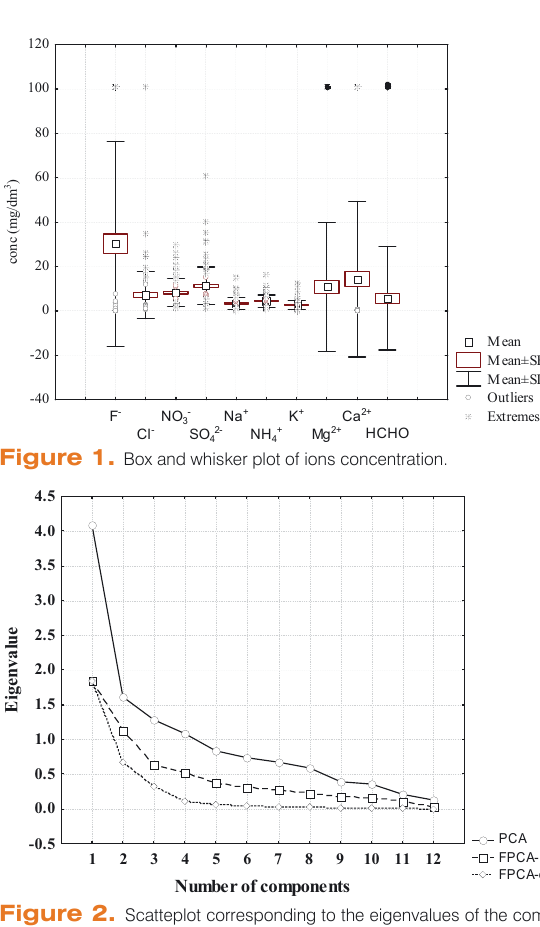
Figure 2. Scatteplot corresponding to the eigenvalues of the com - pared PCA and FPCA algorithms. Table 5 lists the eigenvalues of the correlation matrix, ordered from largest to smallest and shows